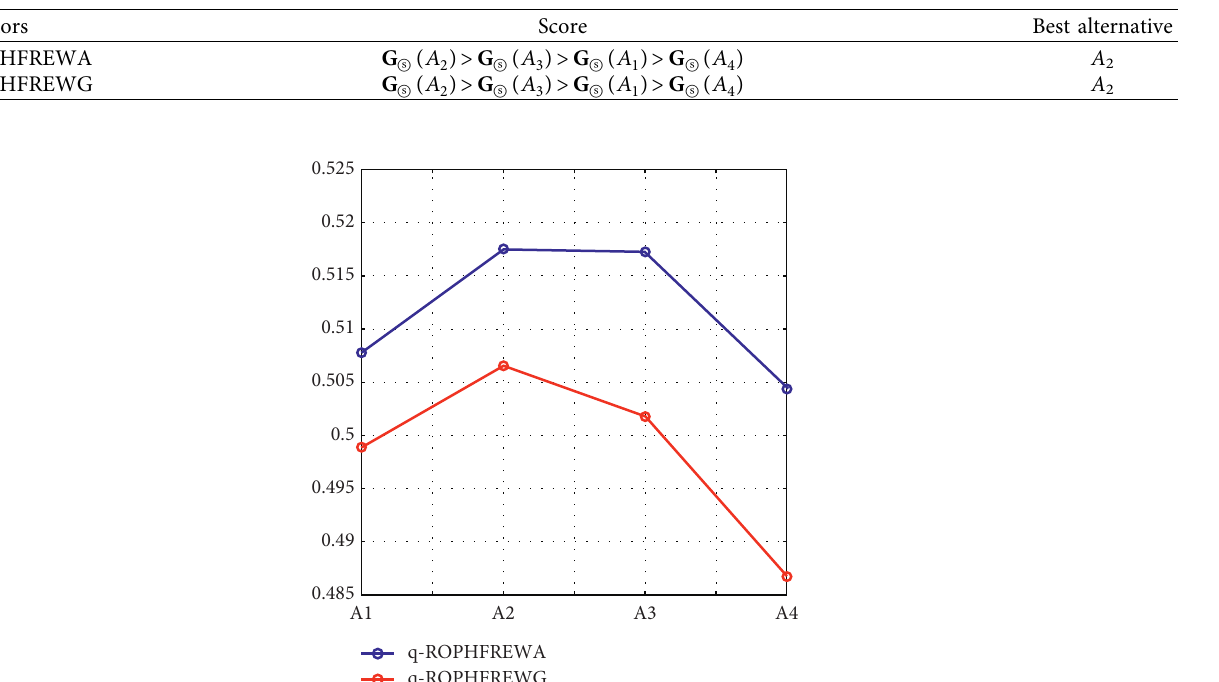
Table 6: Ranking of the alternatives.